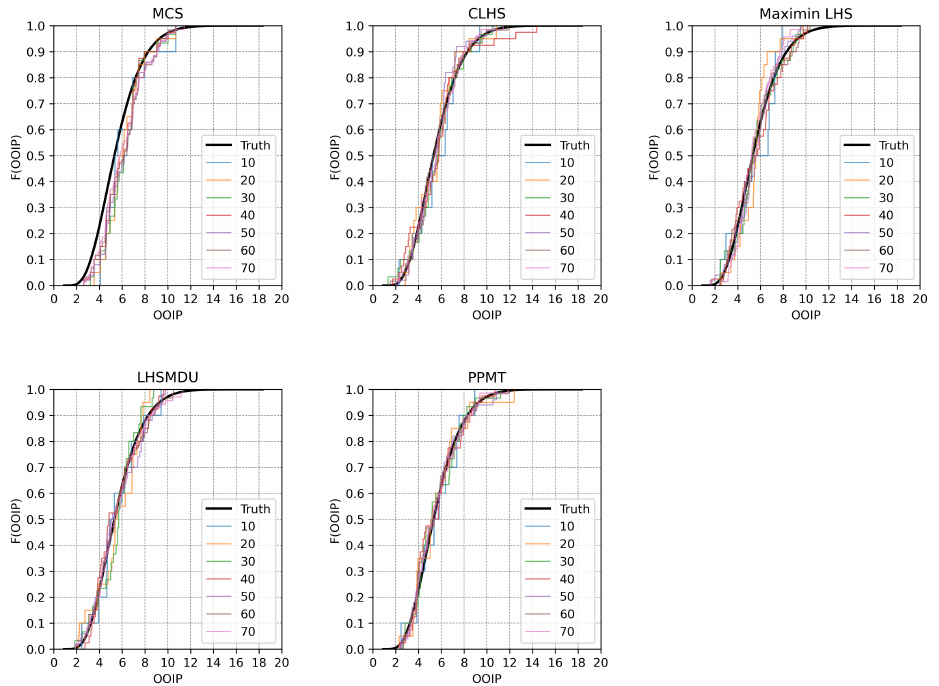
Figure 10. The underlying CDF of the OOIP in the case where the OOIP variables are correlated and the empirical CDFs are generated by each sampling technique considering the small sample sizes.